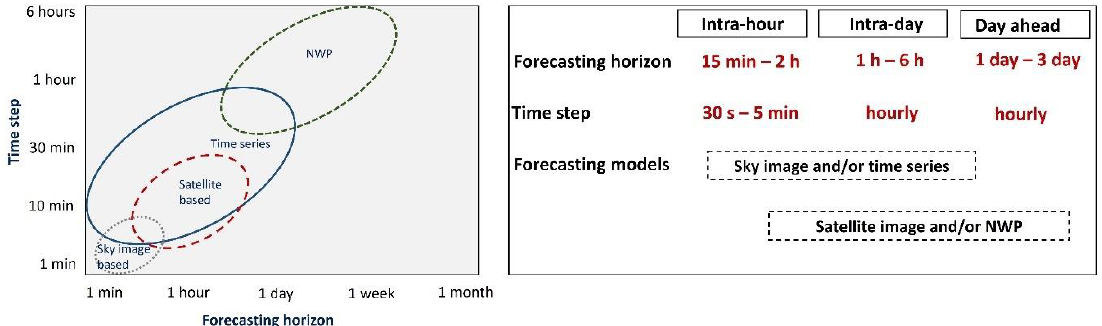
Figure 2. Solar irradiance forecasting techniques in different time horizons and steps .